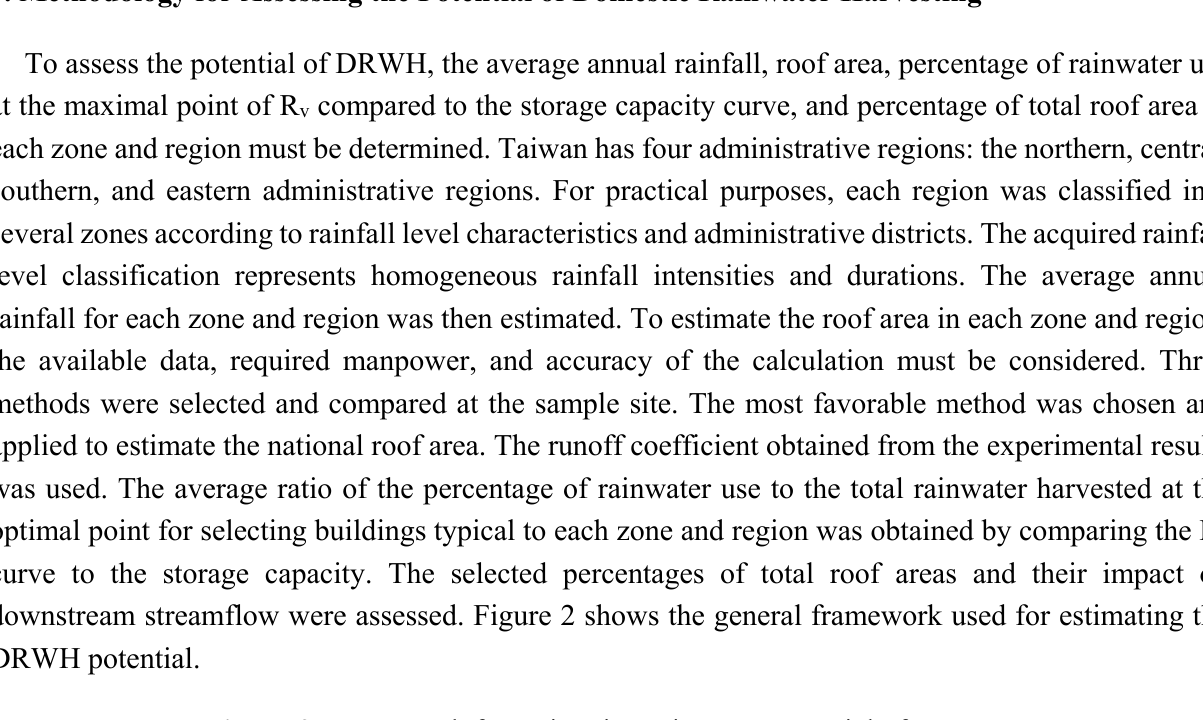
Figure 2. Framework for estimating rainwater potential of